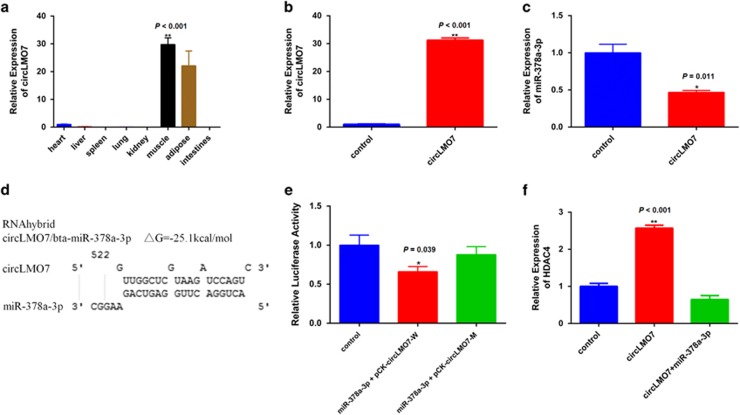
Expression analysis of circLMO7 using qPCR. (a) Expression levels of circLMO7 in different tissues of embryonic cattle. (b) Visualization of the efficiency of circLMO7 overexpression vector pcDNA-circLMO7. (c) Effect of circLMO7 on the abundance of miR-378a-3p. (d) RNAhybrid predicted a miR-378a-3p binding site and provided ΔG values for its interaction with circLMO7. (e) Our miR-378a-3p overexpression vector was co-transfected with psiCHECK2-circLMO7W or psiCHECK2-circLMO7M into bovine primary myocytes. Renilla luciferase activity was normalized to Firefly luciferase activity. (f) mRNA expression of HDAC4 in primary bovine myocytes transfected with circLMO7 and/or miR-378a-3p mimic for 24 h was detected using qPCR. Data are shown as means±S.E.M. for three individuals. *P<0.05